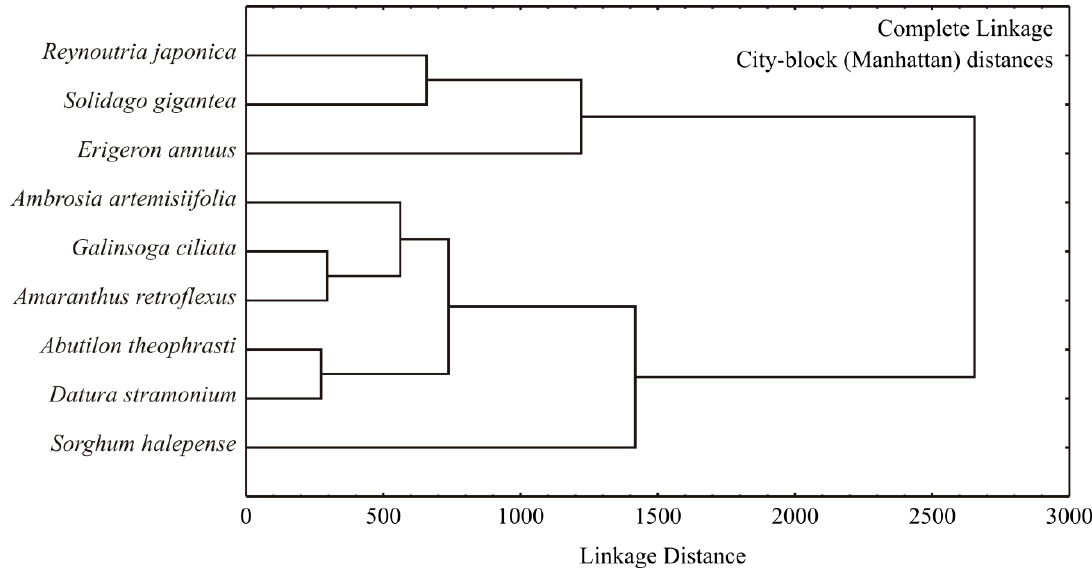
Figure 4. Complete linkage dendrogram for specialized metabolites of IAS.